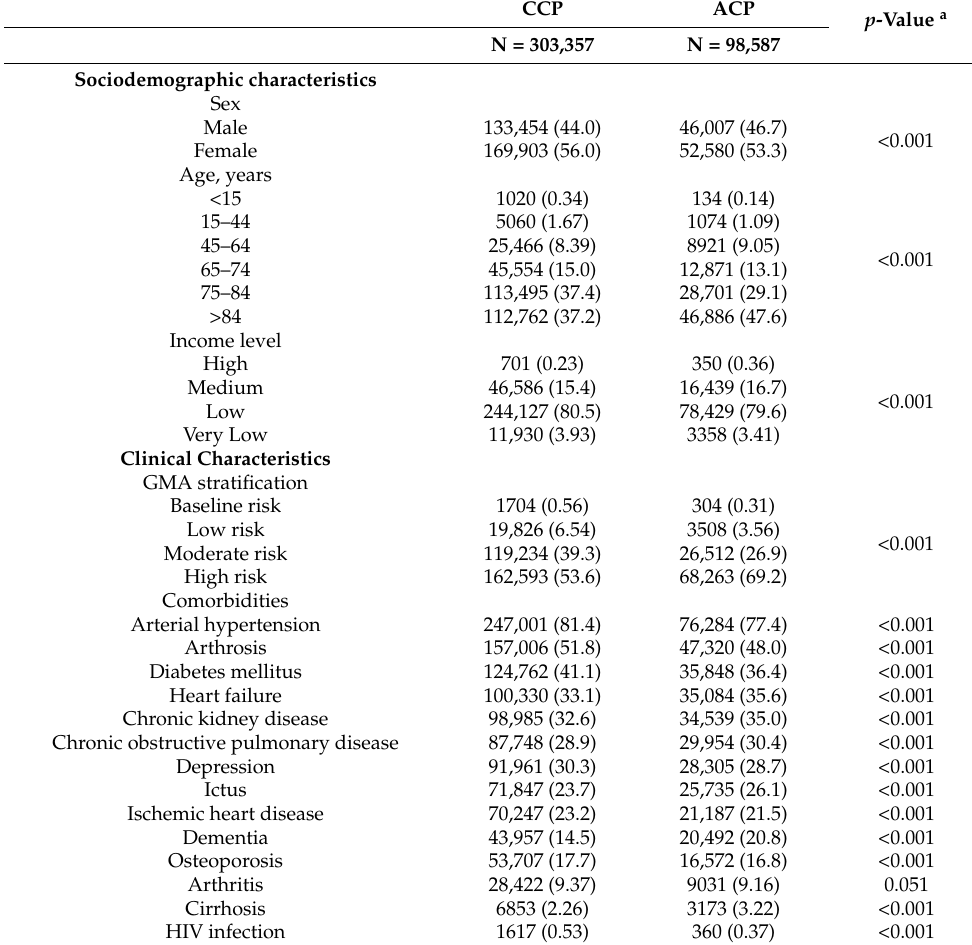
Table 1. Sociodemographic and clinical characteristics of the overall study cohort (2013–2019) according to their identification as complex chronic patients and advanced chronic patients, n (%). CCP ACP p -Value a N = 303,357 N =